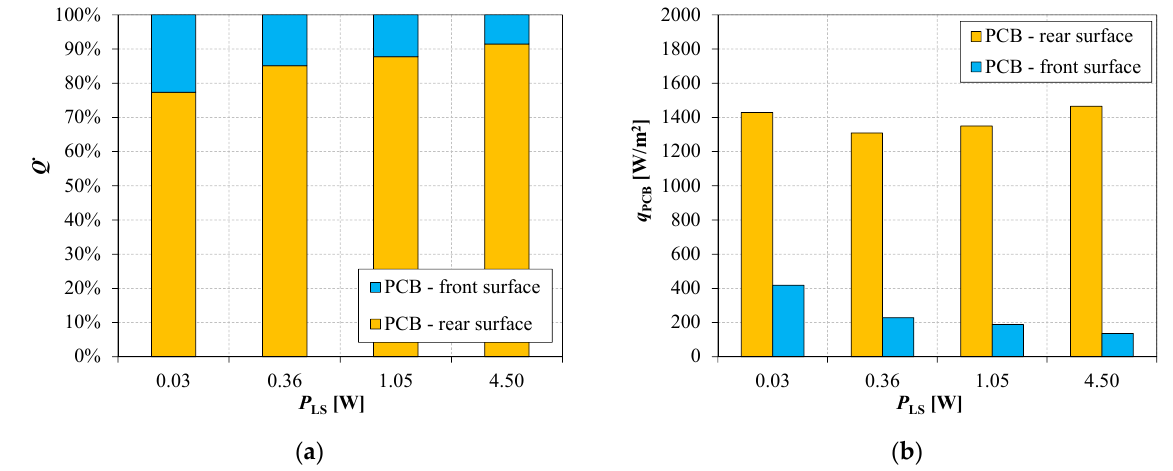
Figure 11. ( a ) The ratio of the heat dissipated from the front and rear surfaces of the PCB for various values of the input power driving SJA. ( b ) Heat flux from the PCB front and rear surfaces for var- ious values of the input power driving SJA. Figure 12a presents the ratio of the heat flow rate of the LED lamp 𝑄(cid:4662) to the electric power delivered to the diode P LED_DC . For the lowest input power of P LS = 0.031 W, the ratio was equal to 𝑄(cid:4662) / P LED_DC = 0.67, while for the highest power of P LS = 4.50 W, it de- creased to 𝑄(cid:4662) / P LED_DC = 0.57. This means that approximately 60% of the electrical energy supplied to the LEDs was converted into heat, while approximately 40% was trans- formed into light.